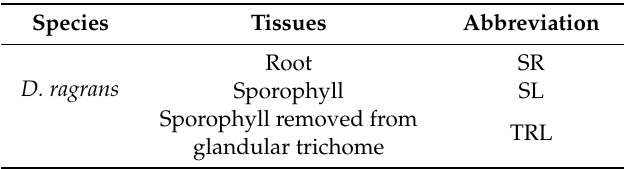
Table 1. The species and the